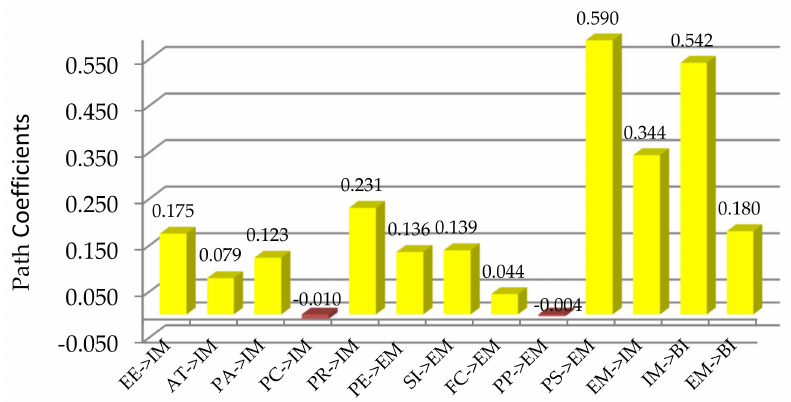
Figure 2. Path coe ffi cients for the inner